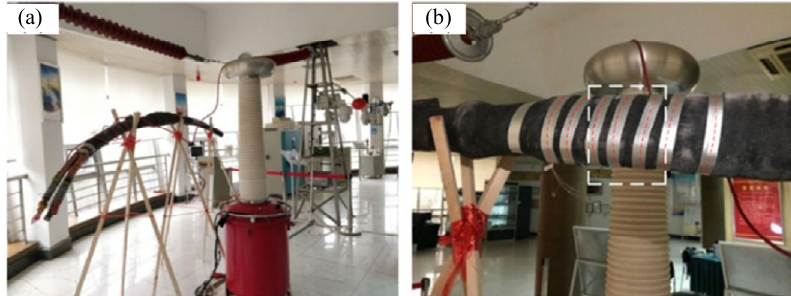
Fig. 11 Partial discharge detection setup: (a) partial discharge generator and (b) sensing fi ber layout